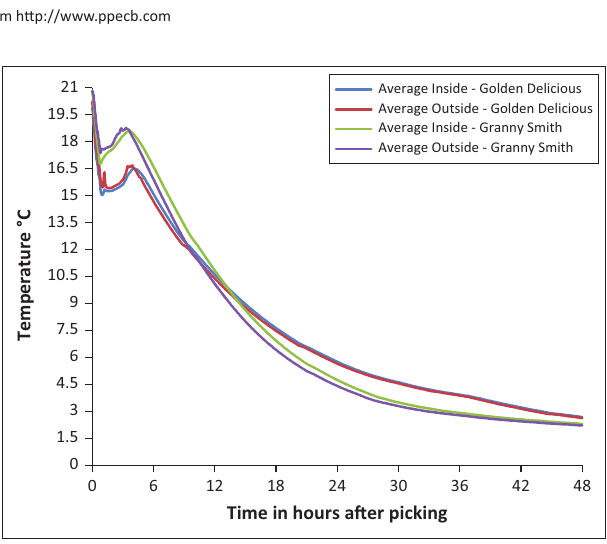
FIGURE 3: Average inside and outside temperature readings.